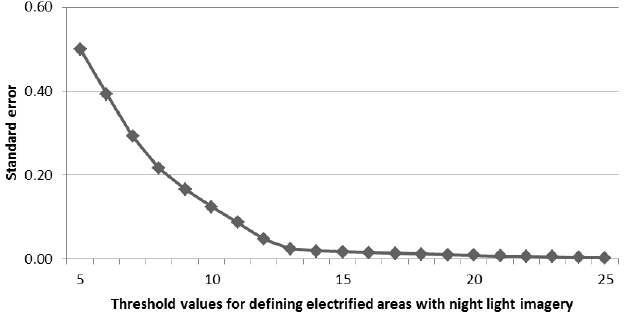
Figure 3. Standard error of calculated electrification rates to IEA statistical electrification rates [58] by using different threshold values for sensitivity analysis of night light imagery. Summary for all considered 45 sub-Saharan African countries.